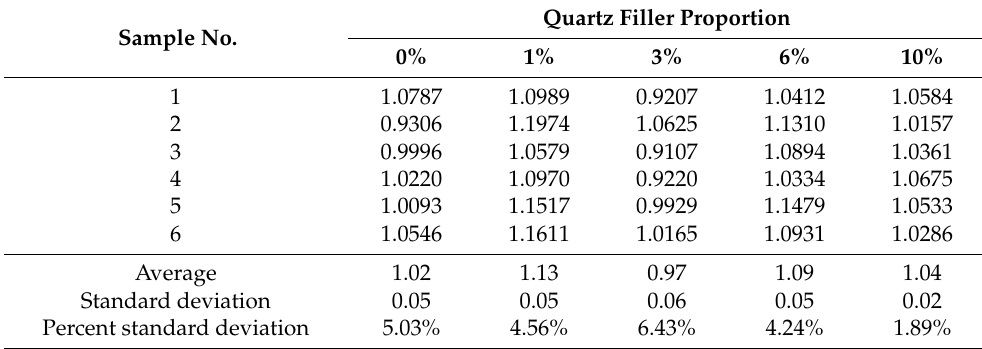
Table 2. The values of the friction coefficient µ f obtained for the Sikafloor matrix composites made using a powder binder, with the different percentages of the particulate filler. Quartz Filler Proportion Sample No.